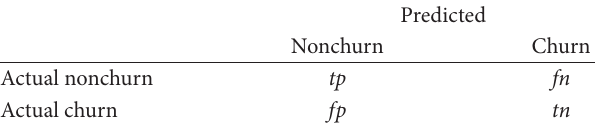
Table 3: Confusion matrix.